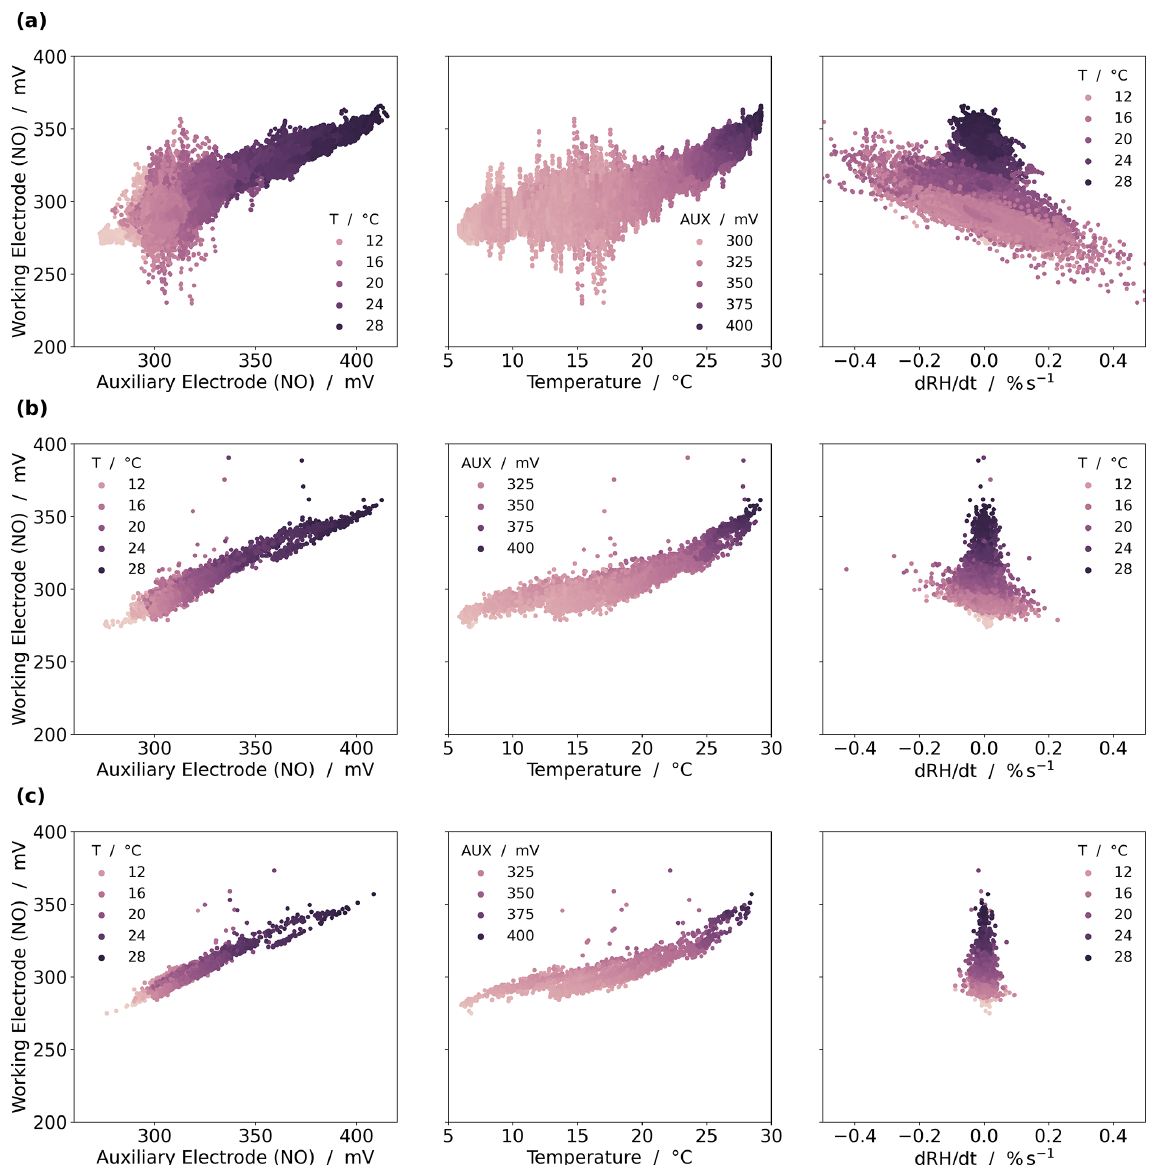
Figure 3. Scatterplots of NO sensor (setup no. 2) for WE vs. AUX, T , and dRH / d t , with different time resolutions of (a) 1s, (b) 30s, and (c) 120s provided per row. The colors are used to show collinearity between AUX and T and that the shift in WE voltages in the dRH / d t plot is a temperature